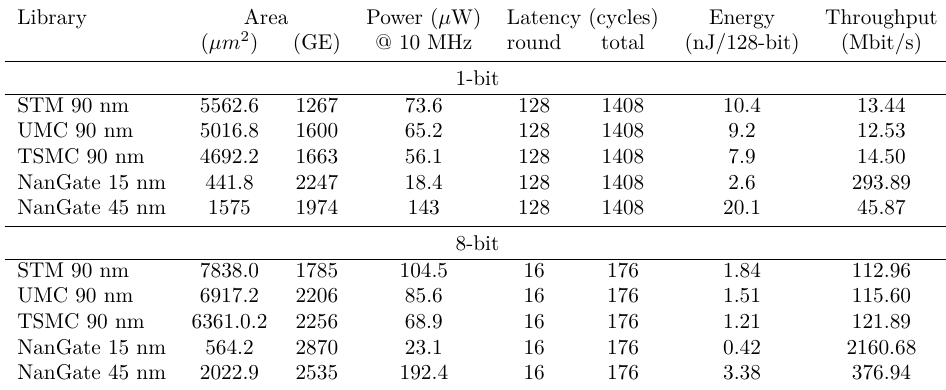
Table 6: Synthesis figures for the AES-128 encryption-only